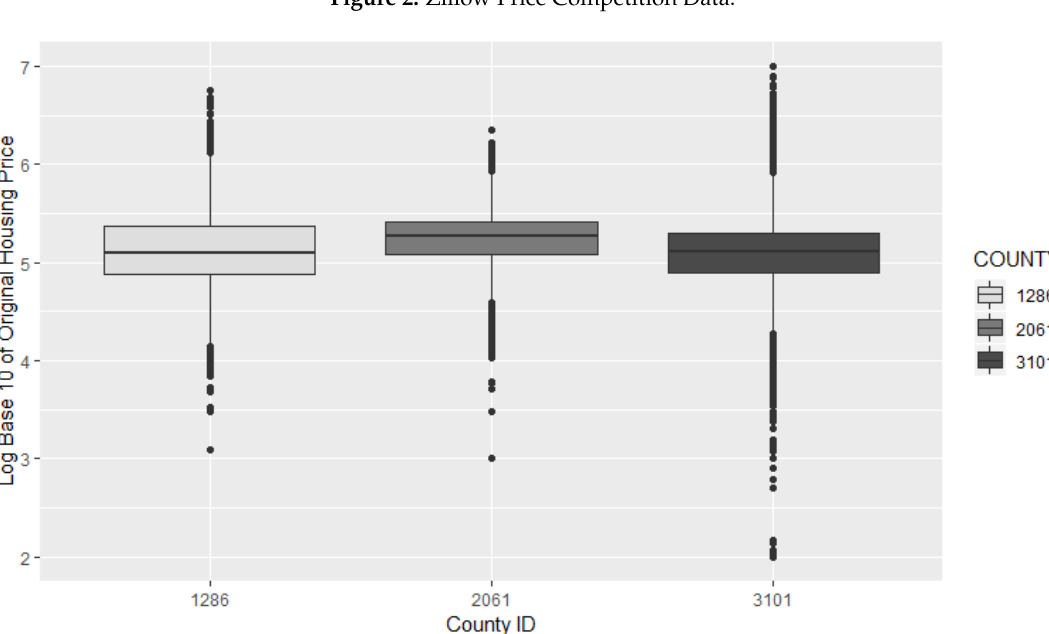
Figure 2. Zillow Price Competition Data.